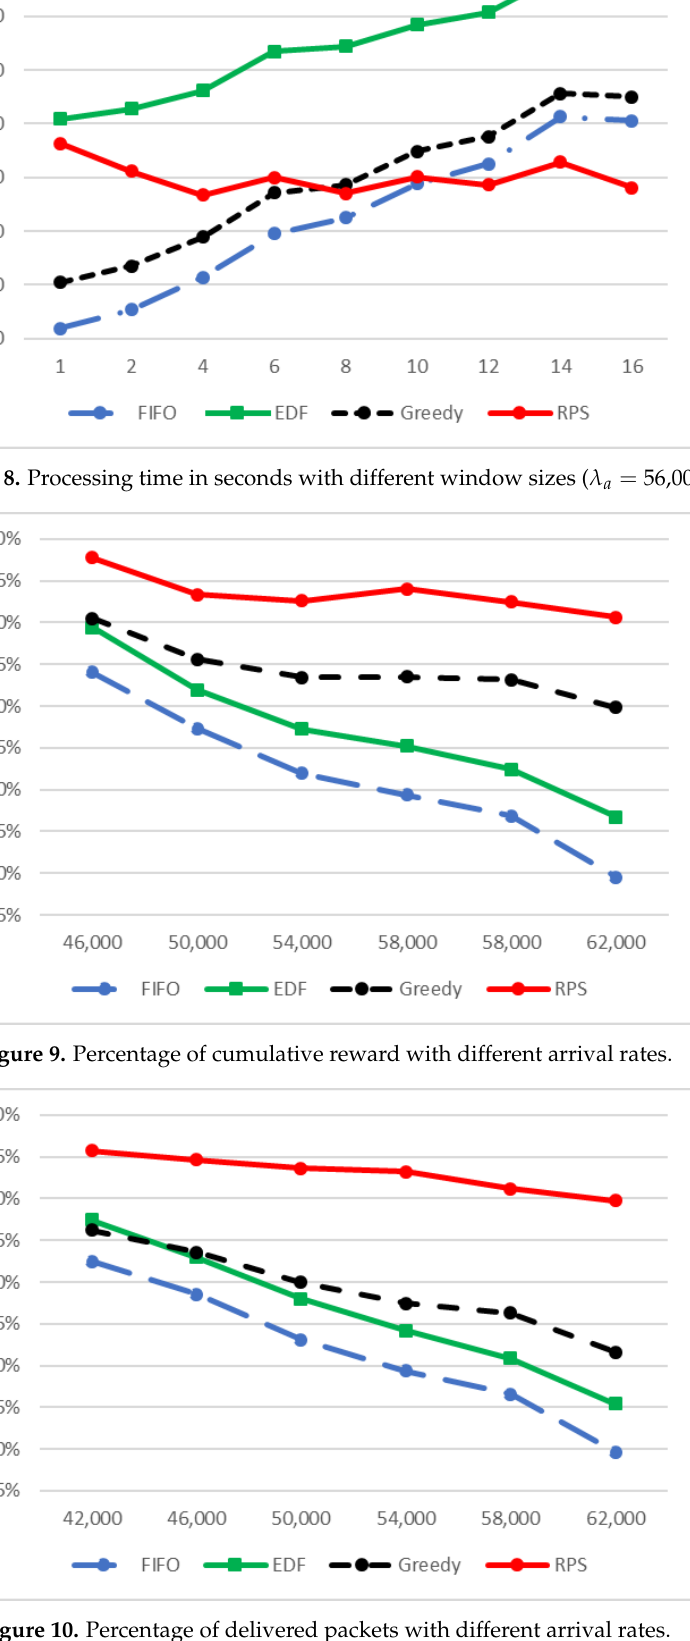
Figure 10. Percentage of delivered packets with different arrival